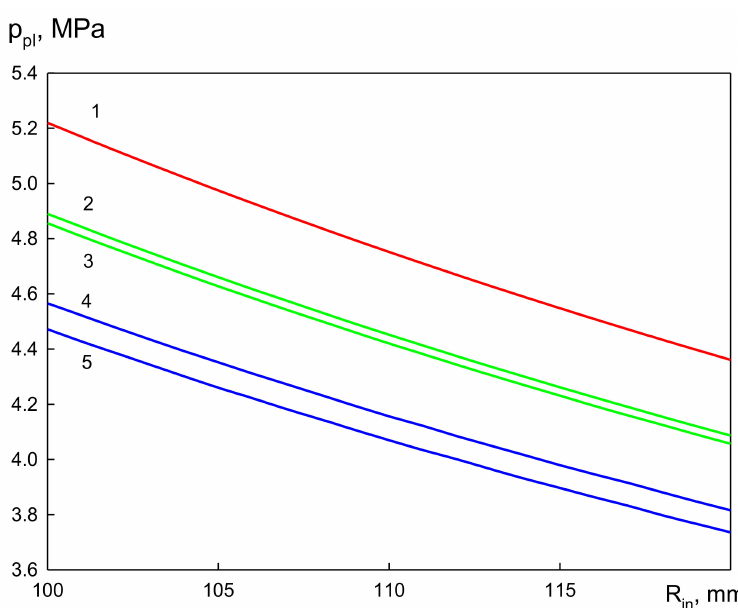
Figure 9. The dependence of the plastic resistance limit on the tube size. Λ p = 100 nm, δ = 10 nm, h = 0.05 m; curve 1– T in = 293 K, T ex = 293 K; curve 2–293, 393; curve 3–393, 293; curve 4–293, 493 and curve 5–493,